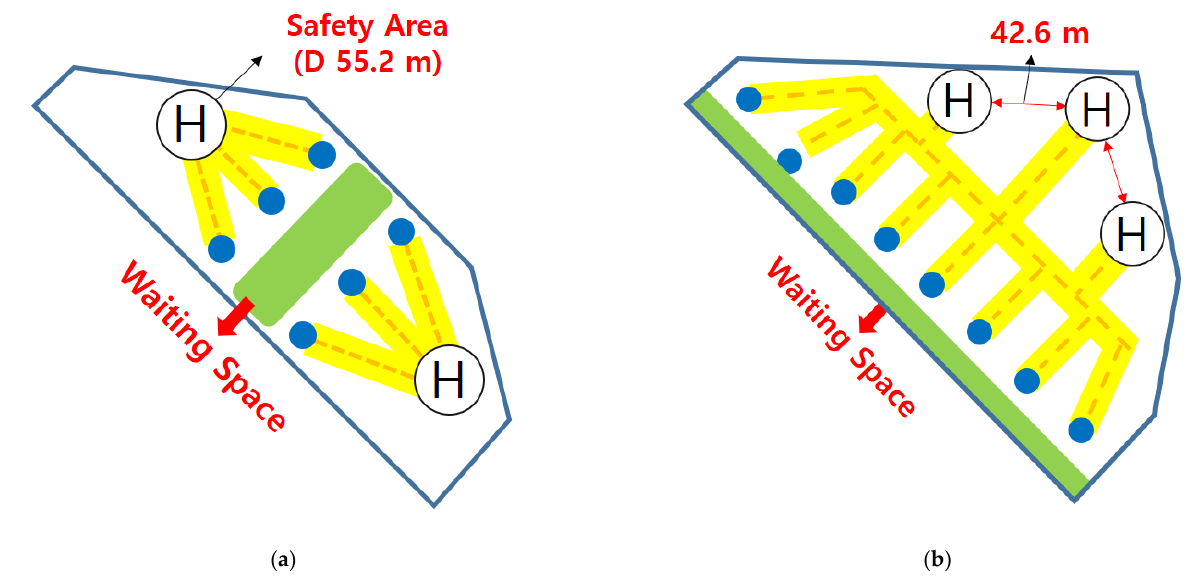
Figure 17. Linear topologies for the Gimpo Airport parking lot that comply with the FAA’s new regulations: ( a ) current parking space; ( b ) expanded parking space.